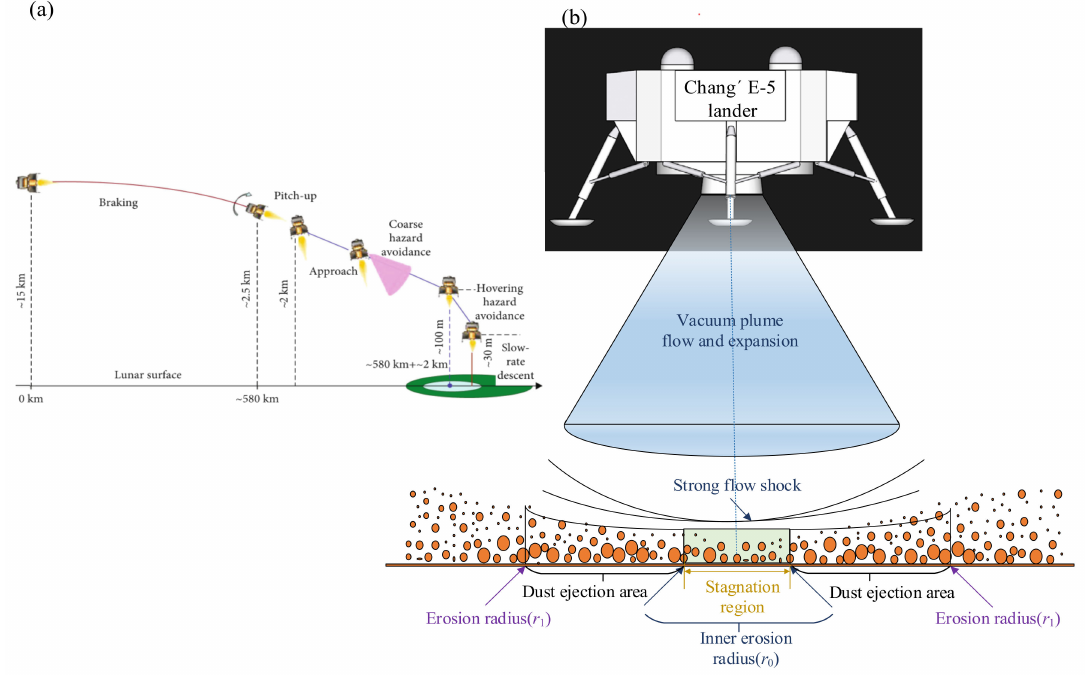
Figure 1. The lander descent trajectory and erosion schematic: ( a ) the lander descent trajectory at different altitudes [27] and ( b ) the vacuum plume flow field associated with lunar surface ero- sion properties.